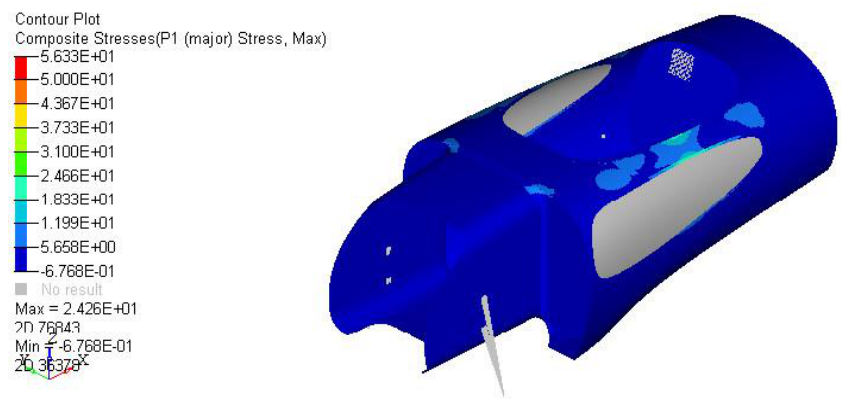
Figure 8. Stress distribution during the exit maneuver.